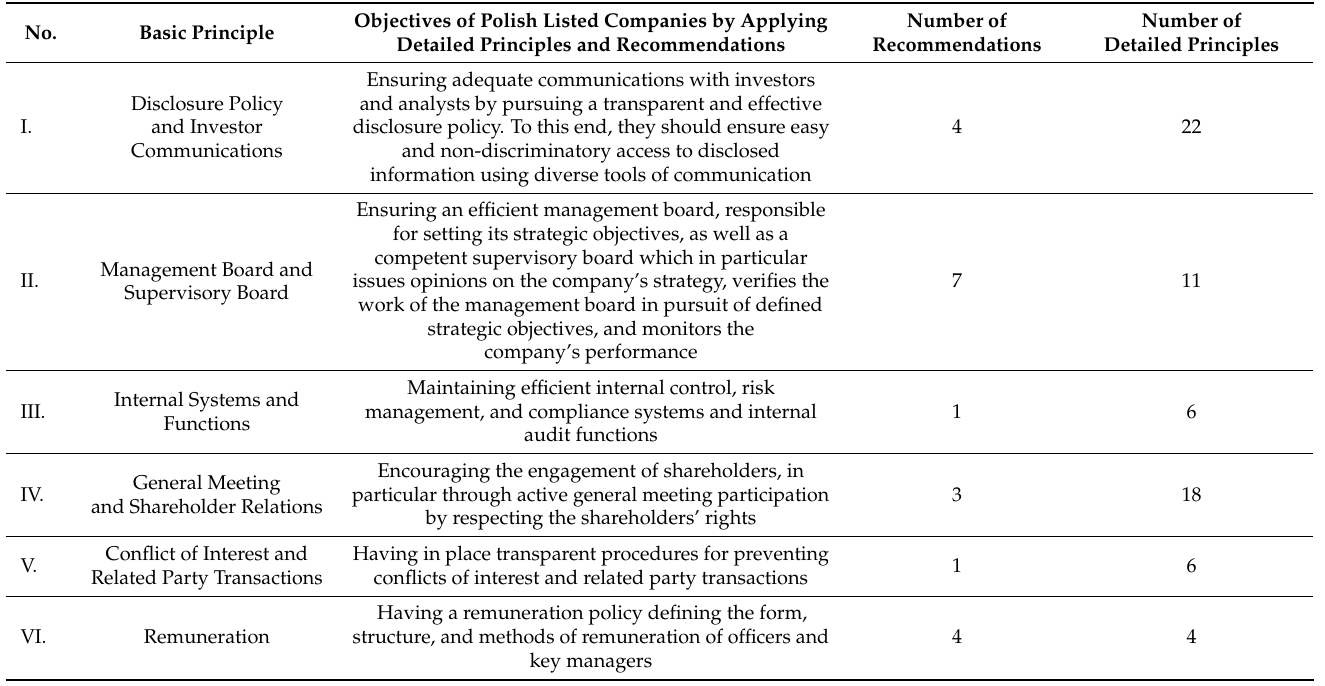
Table 2. Best practices for WSE-LCs 2016—structure